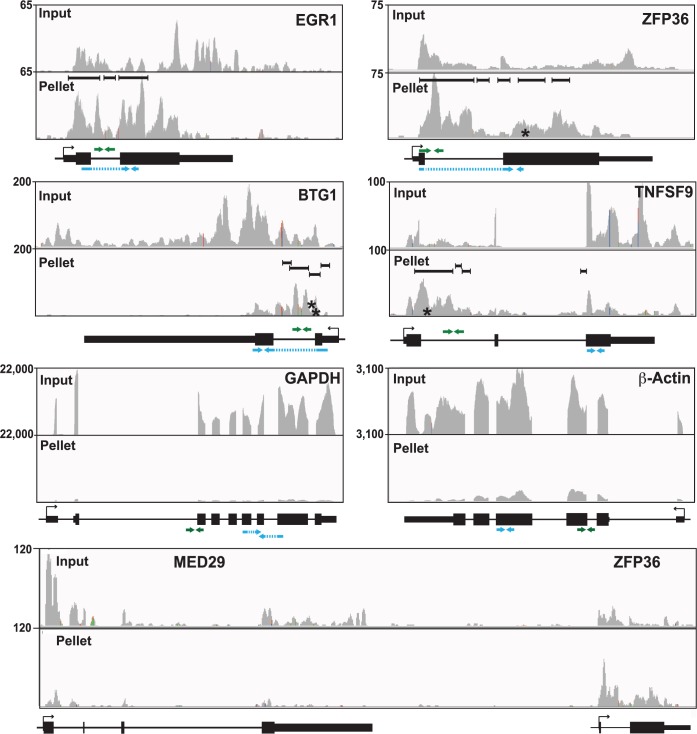
Sequence traces of ORF57-bound human RNAs.Each panel is a screen shot (IGV browser [105]) of the input and pellet samples from one biological replicate. The numbers at the top left of each frame are proportional to the number of reads stacked in a given window. The x-axes in each panel were scaled for each specific transcript. The black bars in the pellet panels denote positions of the enriched clusters and the asterisks denote approximate positions of characteristic mutations. Below each panel is a gene diagram with the TSS and gene orientation indicated by the black arrow. Green and blue arrows above and below the gene diagram indicate the positions of primers used to assay pre-mRNA and mRNAs, respectively. The exons (thick black rectangles) and introns (black lines) are to scale, but the primer and amplicon lengths are not. When possible, primers or amplicons for mRNAs were designed to span exon-exon boundaries (blue dashed lines).